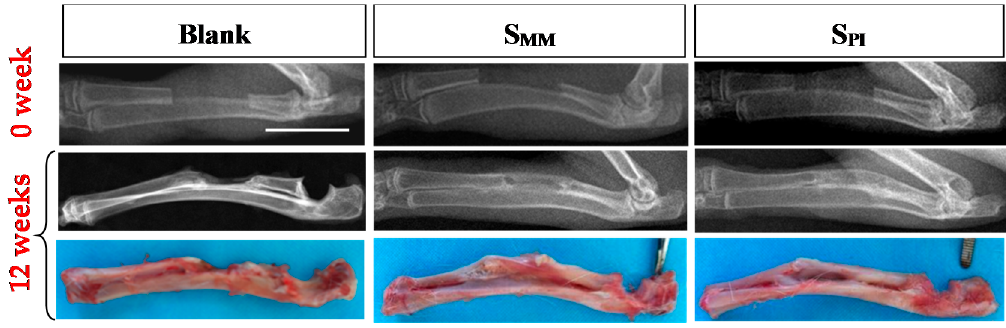
Figure 8. DR of rabbit radius defect at baseline; DR and macroscopic observation in Blank, S MM , and S PI groups at 12 weeks post-surgery. The bar length = 20 mm.